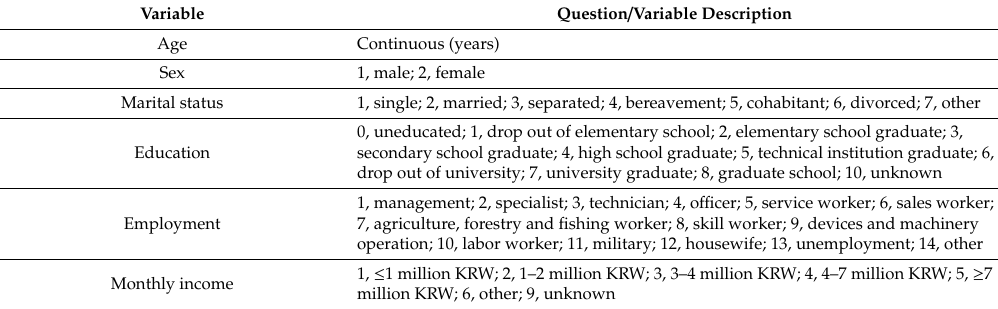
Table A1. Description of demographics and medical history information used in the